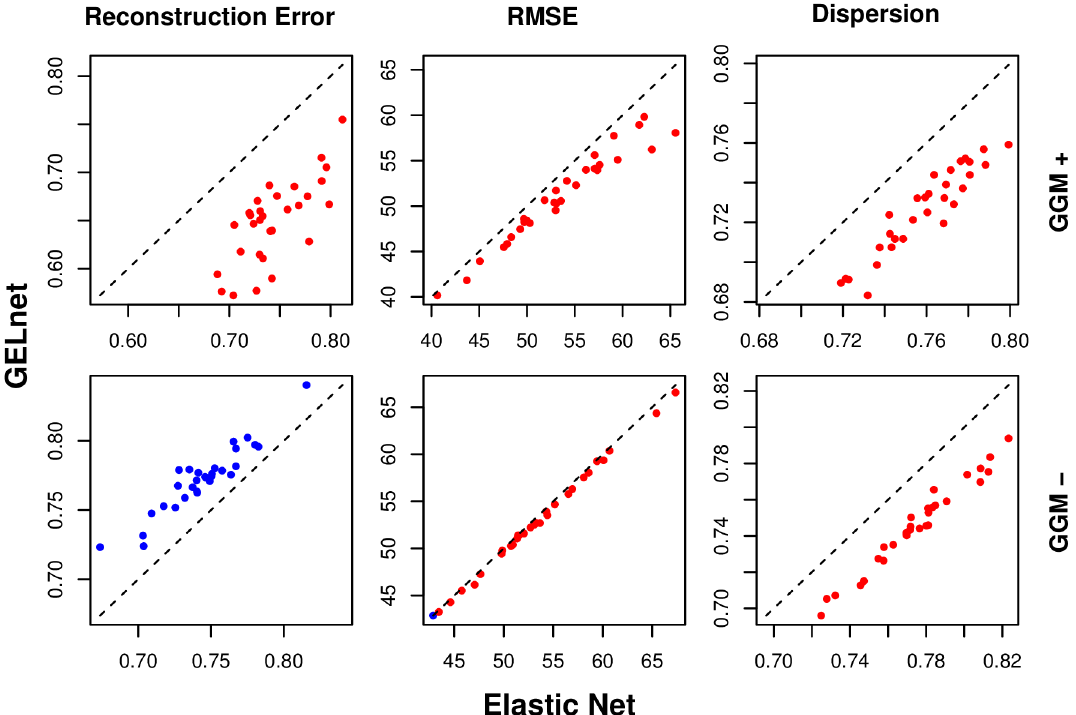
Fig 2. Performance of elastic nets and GELnets on synthetic data generated via a GGM. Plotted are 30 trials of the same experiment. The x- and y-axes in every plot correspond to Elastic Nets and GELnets, respectively. The top three plots show the scenario where the GELnets were provided the true feature- feature relationships, while the bottom three plots correspond to the scrambled network case. Lower values are better for all three performance metrics, and the points are colored in red whenever the performance metrics are lower in the GELnet models, and blue otherwise.